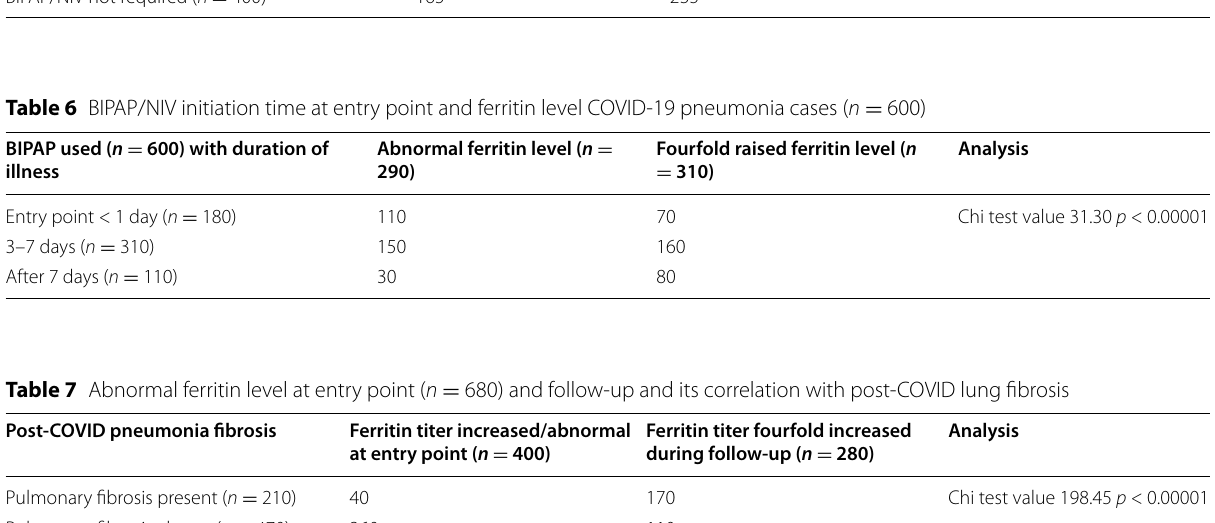
Table 5 Correlation of BIPAP use with ferritin level in COVID-19 pneumonia cases ( n BIPAP/NIV